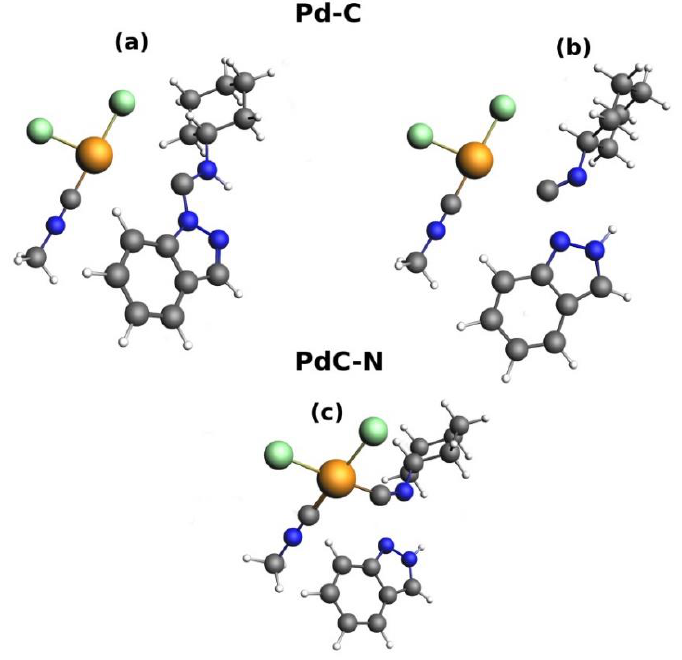
Figure 2. Schematic depictions of the fragments considered for the Pd–C interaction in Z - P1 ( a ) and TS14 ( b ) and for the PdC–N Ind interaction in TS14 ( c ). Analogous fragmentation schemes were used for 1 ( a ), Z - P2 ( a ), and TS6 ( b, c ).